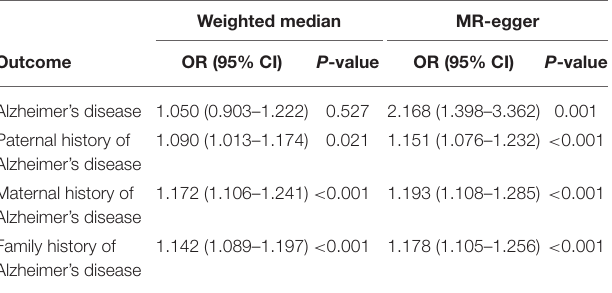
TABLE 2 | Associations between genetically predicted LDL-C and Alzheimer’s disease in sensitivity analyses using the weighted median and MR-Egger methods. Weighted median MR-egger